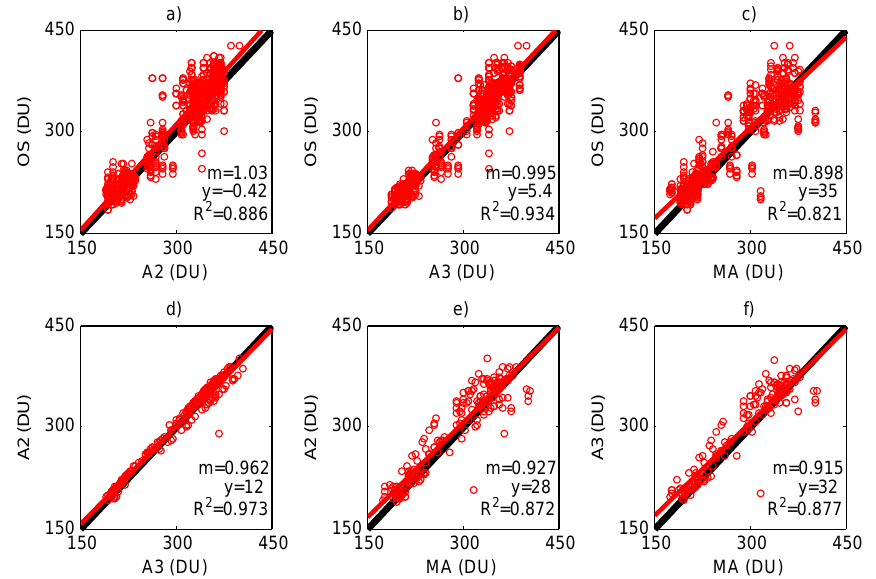
Fig. 6. Correlations between satellite 14–52km ozone partial columns. Red lines indicate linear fit ( m =fitted slope, y =fitted y-intercept). Black lines indicate 1-1. Instrument abbreviations are given in Table 1.